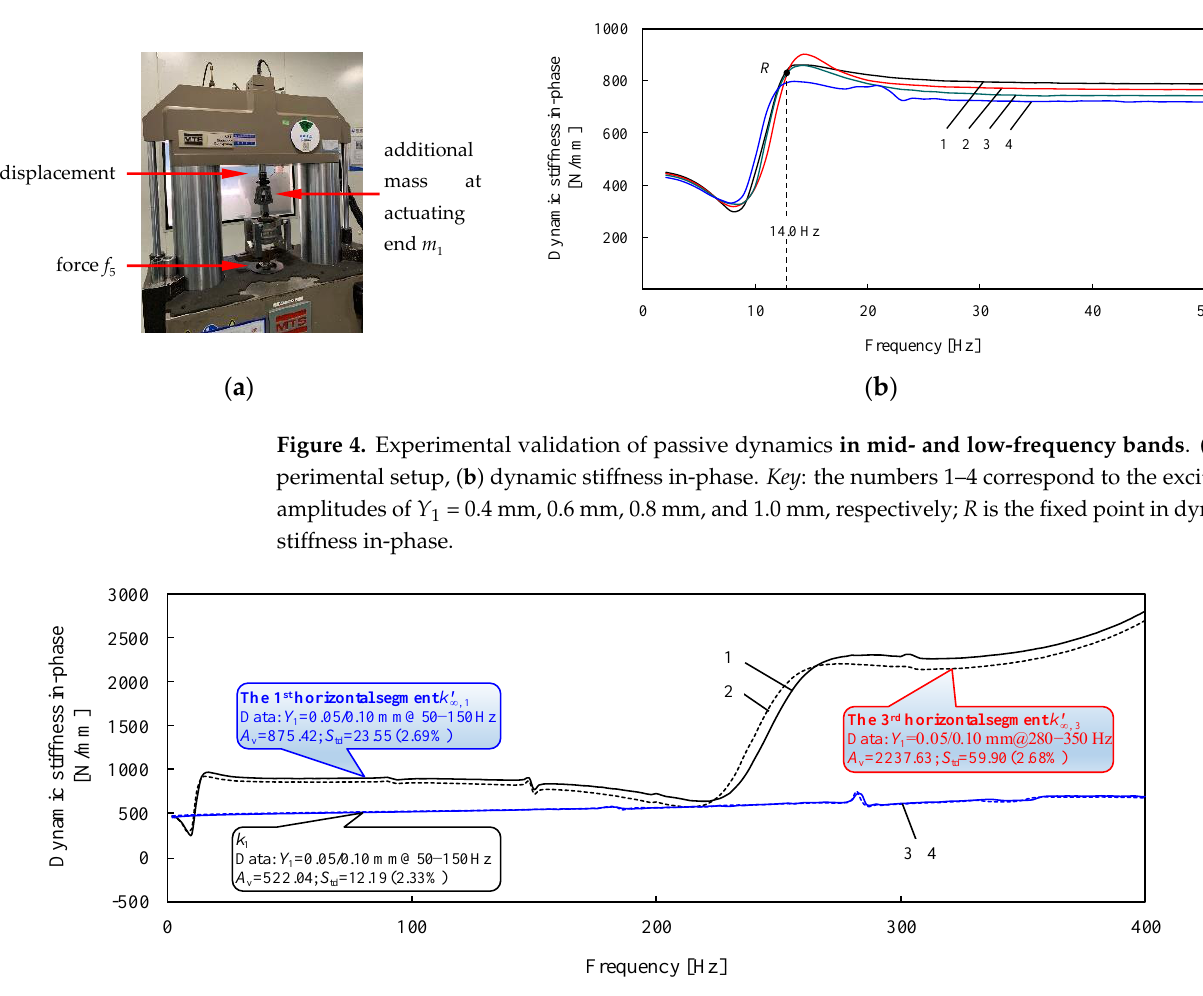
Figure 5. Experimental validation of passive dynamics in mid- and high-frequency bands . Dynamic stiffness in-phase and the 1st and 3rd horizontal segments; Key : numbers 1 and 2 correspond to the excitation amplitudes of Y 1 = 0.05 mm and 0.10 mm; numbers 3 and 4 correspond to Y 1 = 0.05 mm and 0.10 mm for the main rubber spring of the AHM-IT-DM-OCA.